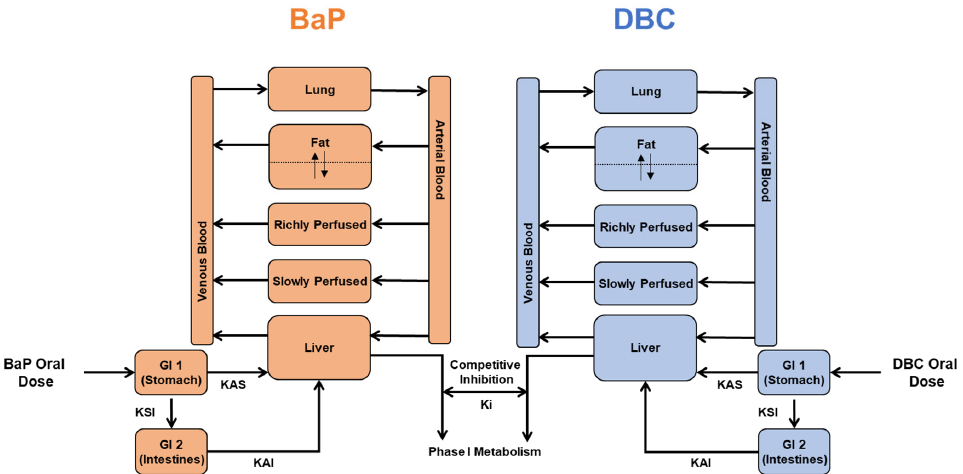
Figure 1. Schematic of a physiologically based pharmacokinetic (PBPK) interaction model for benzo[a]pyrene and dibenzo[def,p]chrysene (DBC). We modified previously published PAH models [18,19] to include competitive inhibition of the metabolism of both parent compounds (i.e., DBC inhibits BaP metabolism, and BaP inhibits DBC metabolism). The interaction PBPK model simulated two scenarios: (1) a competitive metabolism between BaP and DBC (i.e., using measured K i values) and (2) no competitive metabolism (i.e., K i values set to 1 × 10 99 μ M, indicating that the inhibition of PAH metabolism requires a very high inhibitor concentration). For each scenario, the model simulated 16 oral doses of BaP and DBC ranging from 0.1 ng to 100 kg (increasing by a factor of 10) for a grand total of 256 exposure combinations.